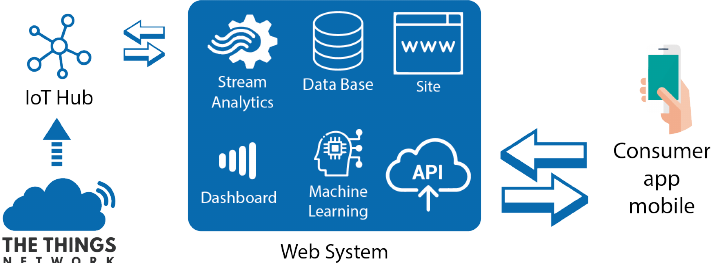
Figure 1. Smart Grid Application Architecture as a